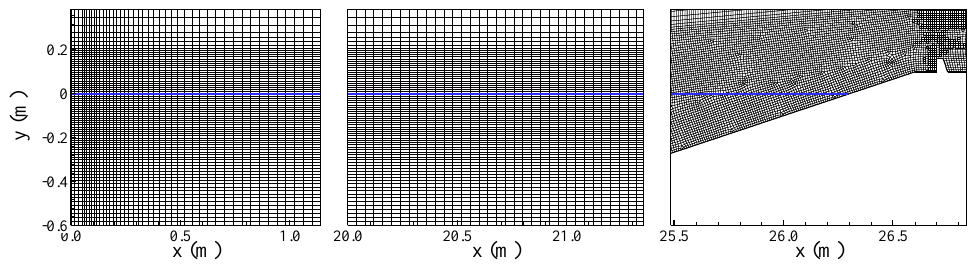
Figure 12. Details of the mesh near the wave-maker, along the flume and in the proximity of the dike and vertical wall. The blue line indicates the SWL.